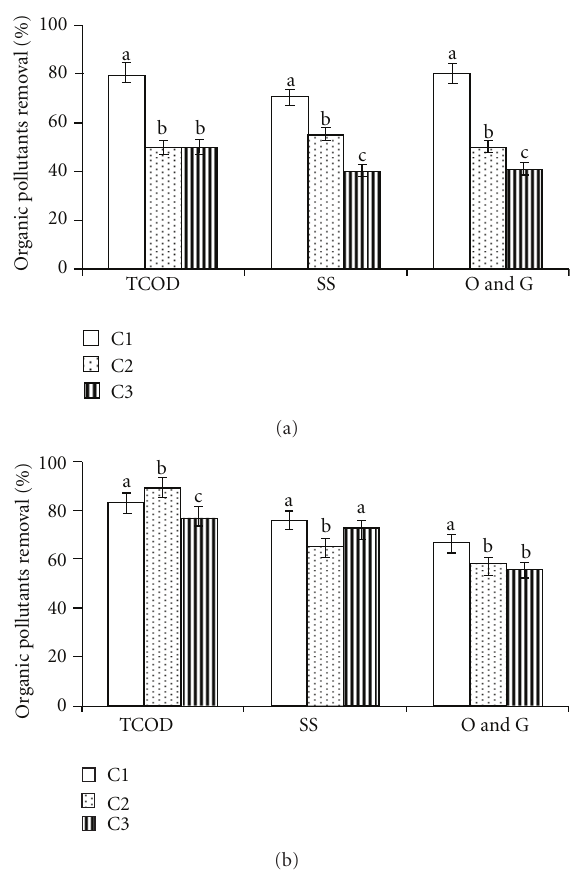
Figure 3: Process performances in (a) the sludge zone and (b) the packed zone of AHR.